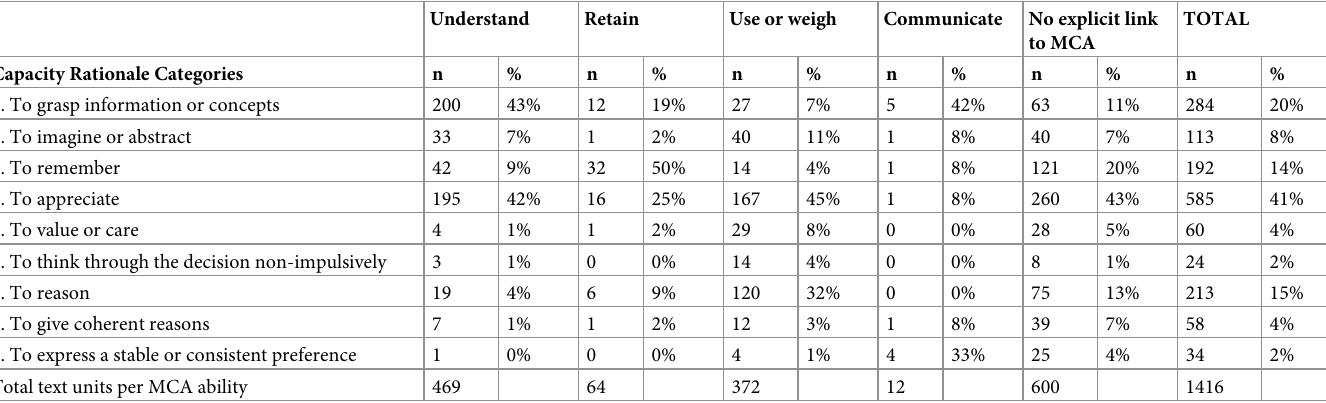
Table 3. Frequency of capacity rationales linked to each MCA criterion 1, 2